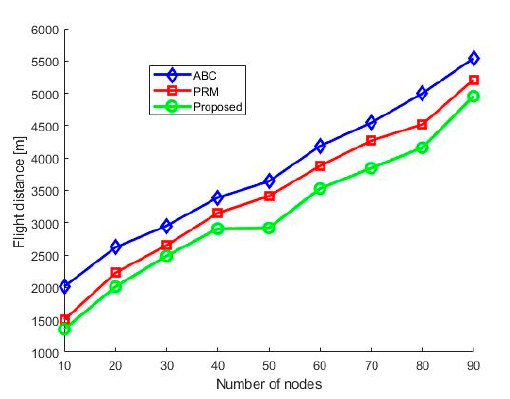
Figure 9. Total distance encompassed.